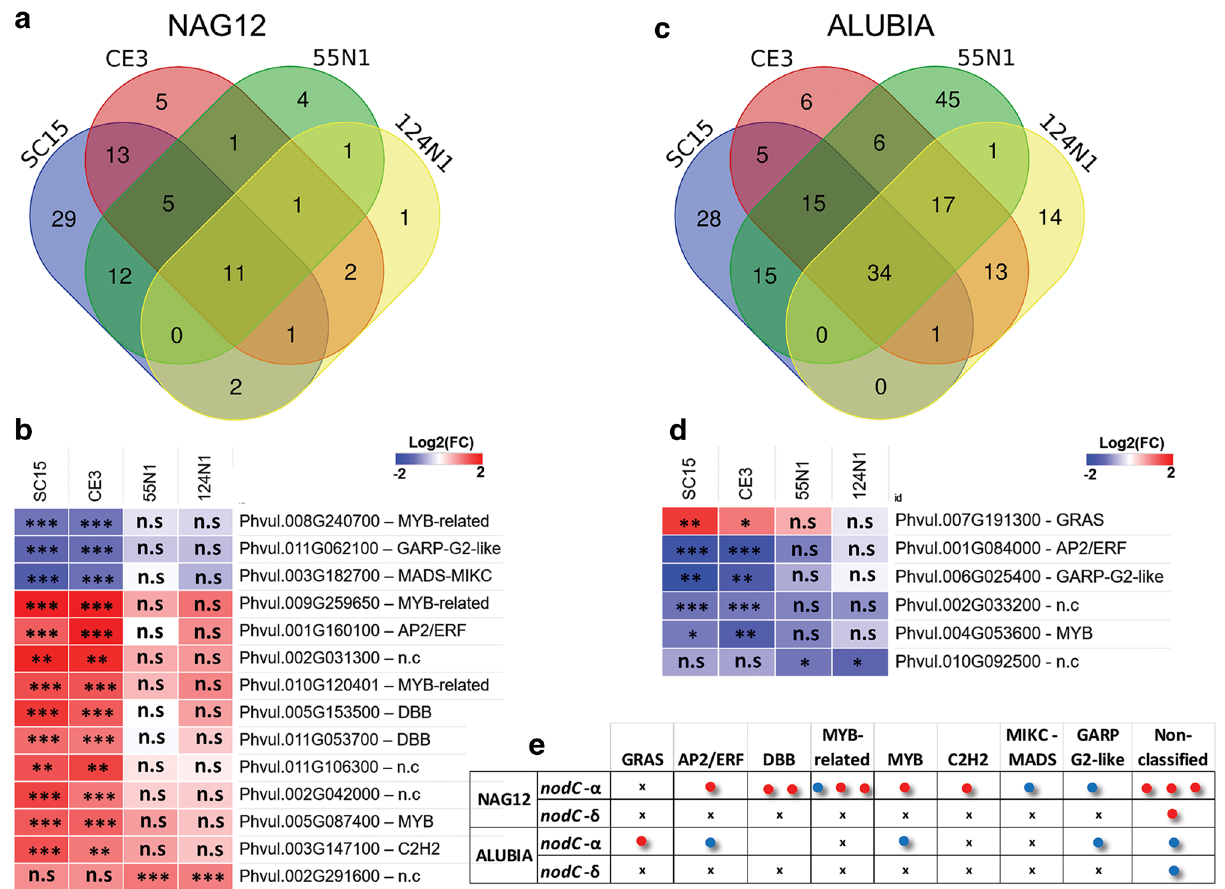
Figure 6. Transcription factors modulated by R. etli inoculation in each P. vulgaris accession. Venn diagrams representing the number and overlap of DEGs encoding transcription factors in NAG12 ( a ) and Alubia ( c ) after inoculation with the indicated R. etli strains. Heatmaps show Log 2 fold change (FC) in transcript levels of DEGs encoding transcription factors that are differentially accumulated in NAG12 ( b ) and Alubia ( d ) in response to nod C-α (SC15 and CE3) or nod C-δ (55N1 and 124N1) R. etli strains as compared with YEM treated roots. Locus ID and the transcription factor family are indicated on the right. ( e ) Differentially expressed transcription factors classified according to iTAK Database. Classification is indicated in the top row. Each circle represents an up- (red) or down-regulated (blue) transcription factor coding gene. x indicates that there is no DEGs within a particular family of transcription factors in that combination of accession and